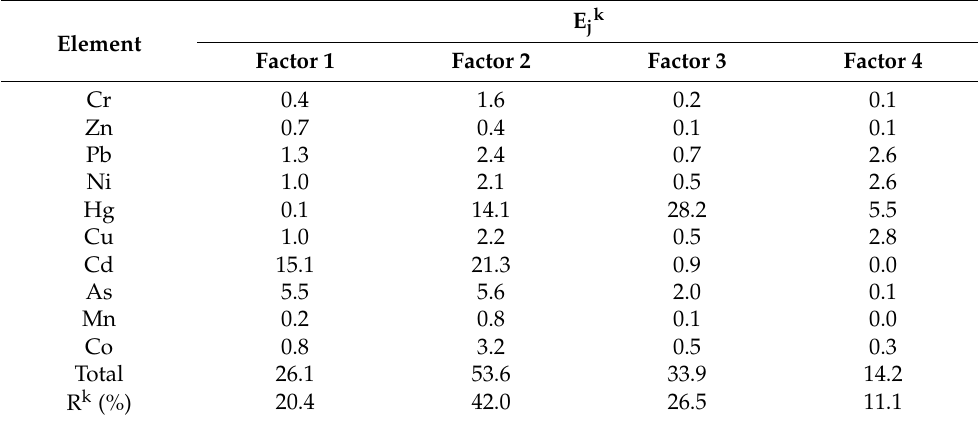
Table 6. The potential ecological risk from different sources.